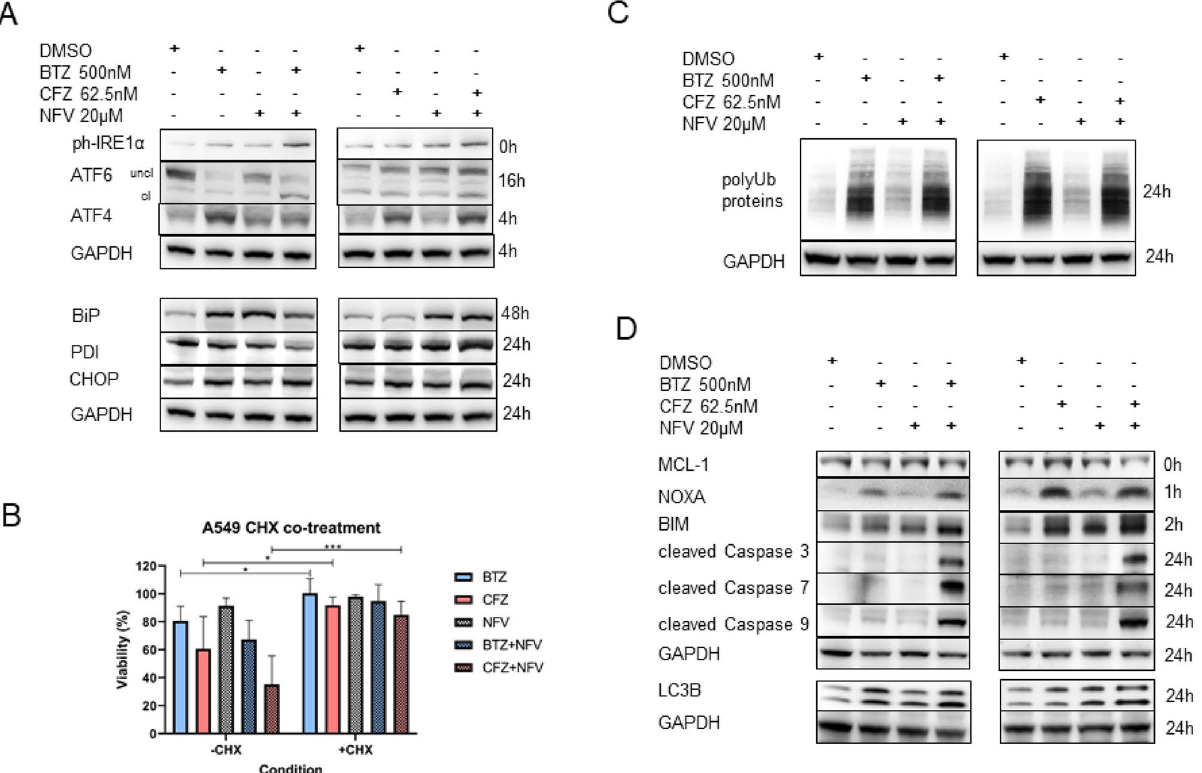
Figure 3. ER stress and apoptosis induction by proteasome inhibitors in combination with nelfinavir in NSCLC cells. ( A ) Induction of the proteins involved in the UPR upon treatment with bortezomib and carfilzomib alone or in combination with nelfinavir. Western blot analysis was performed with A549 cells at the indicated time points after 2 h of pulse treatment with proteasome inhibitors with or without nelfinavir. Representative images of three independent experiments are shown. ( B ) Cytotoxicity of bortezomib, carfilzomib and nelfinavir in the presence or absence of 1 µg/ml cycloheximide (CHX) pretreatment for 3 h. Cell viability was assessed 48 h after 2 h of pulse treatment with proteasome inhibitors, followed by incubation in drug-free media or nelfinavir. Data represent the mean ± SD of at least three replicates. ( C ) Accumulation of polyubiquitinated proteins upon treatment with bortezomib and carfilzomib alone or in combination with nelfinavir. Western blot analysis was performed with A549 cells at the indicated time points after 2 h of pulse treatment with proteasome inhibitors alone or in combination with nelfinavir. Representative images of three independent experiments are shown. ( D ) Induction of apoptosis upon treatment with bortezomib and carfilzomib alone or in combination with nelfinavir. Western blot analysis was performed with A549 cells at the indicated time points after 2 h of pulse treatment with proteasome inhibitors alone or in combination with nelfinavir. Representative images of three independent experiments are shown. * represents p < 0.05; *** represents p <